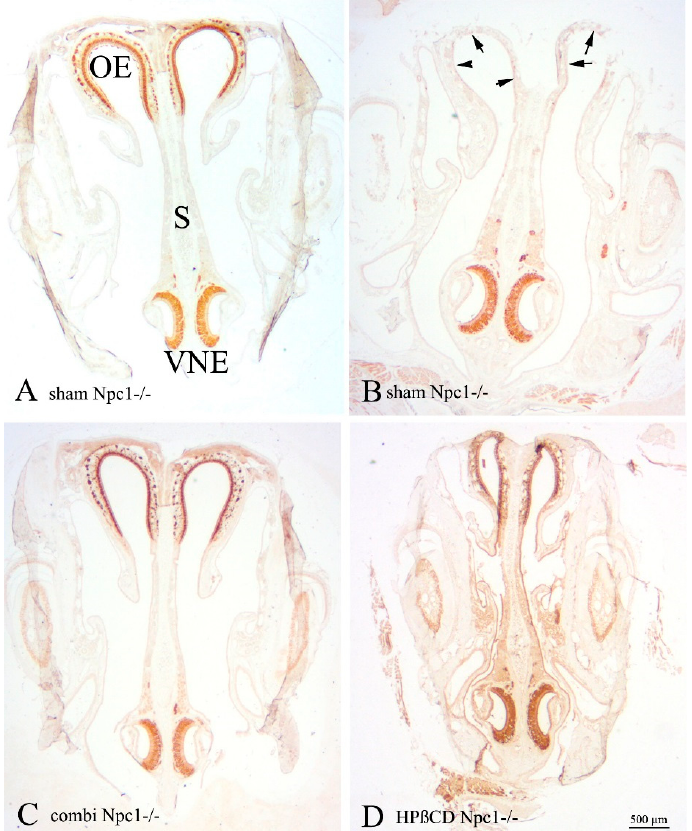
Figure 5. Comparison of OMP immunoreactivity (IR) in both nasal chemosensory organs. ( A ) OMP-IR in sham-treated Npc1 +/+ mice is regularly distributed in olfactory receptor neurons (OE) and in vomeronasal receptor neurons (VNE); ( B ) sham-treated Npc1 − / − mice present highly damaged and almost OMP-IR absent neurons within the OE (arrows), whereas the VNE appears normal; ( C , D ) both treated animal groups, however, show almost normal OMP-IR indicating a protective effect of both treatment strategies. The VNE does not show changes of OMP-IR in neither